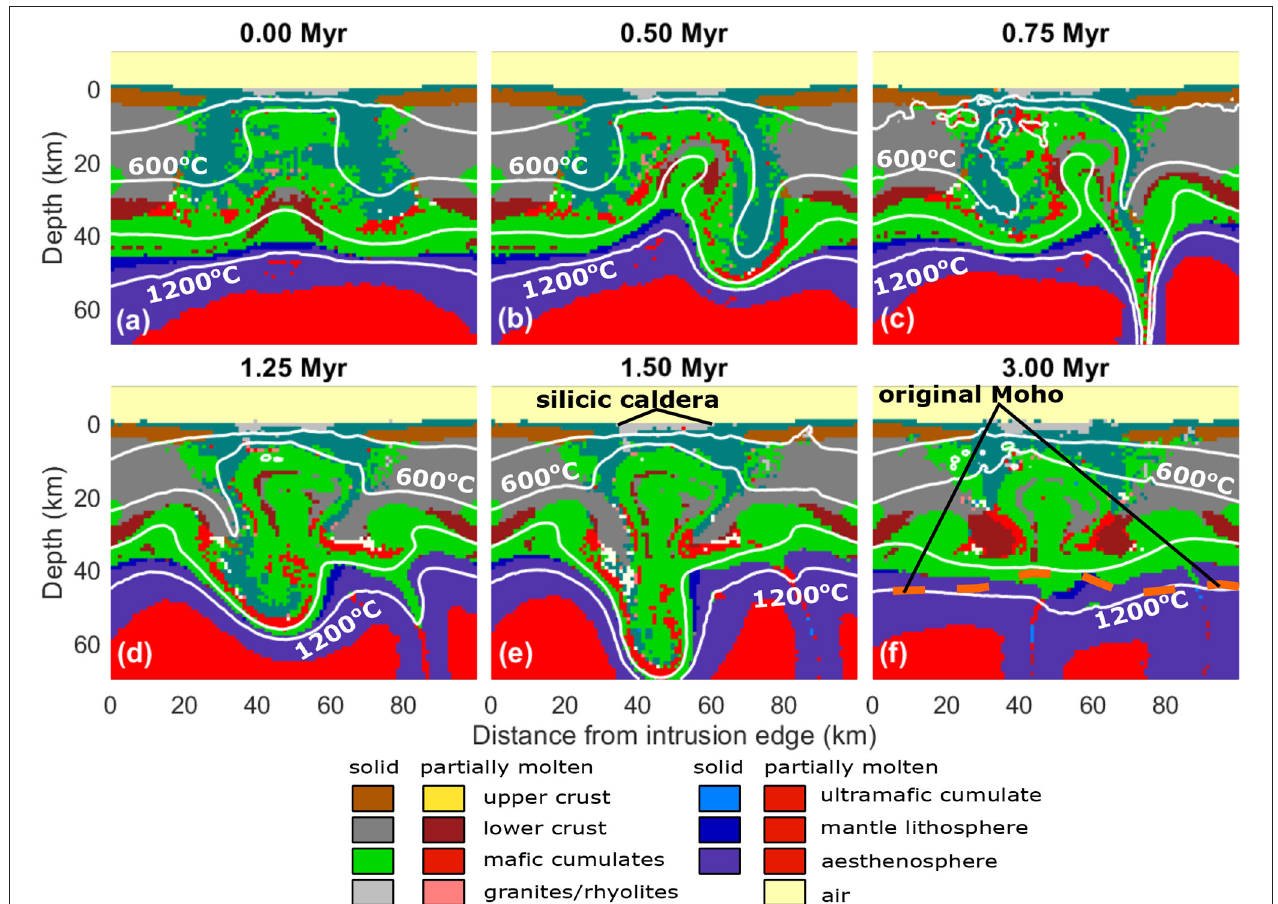
FIGURE 10 | Thermomechanical model of delamination-triggered mantle melting and surface volcanism. White lines are 200 ◦ C temperature contours. (a) 4 Myr after the initially 35km-thick crust has been thickened to nearly 50km by repeated additions of basalt to the crust, basalt addition and heating the crust results in the first signs of Rayleigh-Taylor instabilities in the Moho, (b,c) Over the next 1.25 Myr, this develops into a drip which removes the lowermost crust including most of the mafic cumulates, and continental lithosphere, drawing hot mantle up into the resulting space, and causing extensive melting. (d,e) From 1.5 to 2.5 Myr after the start of the delamination event, further delamination occurs on the left side of the model, causing another smaller surge of melting. (f) Finally, the lower crust cools and begins to solidify after the surge in mantle melting, and a new equilibrium with thinner, ∼ 30km thick crust begins, starting a new